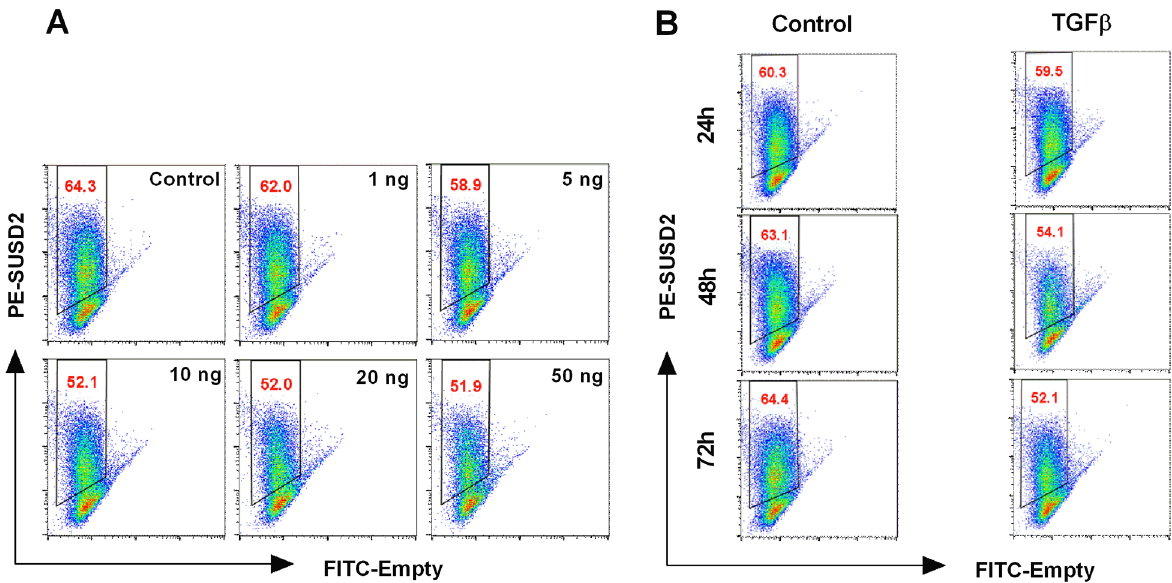
Fig 1. Titration and Time-course of the TGF β effect on SUSD2 +Ishikawa cells. (A) Representative originalFACS plots showingthe effect of increasing TGF β concentrations (Control, 1, 5, 10, 20, 50 ng/ml) for 72h on the percentage of SUSD2+ expressingcells. (B) Representative originalFACS plots showingincreasingabundance of SUSD2+ cells at 24h, 48h and 72h time points with TGF β (10 ng/ ml) or untreated(Control).